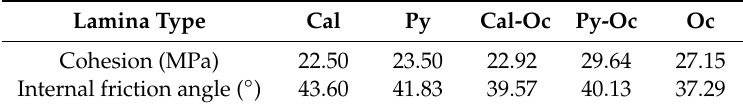
Figure 7. Shear strength parameters for different Longmaxi Shale laminae. Table 2. Shear strength parameters of the Longmaxi Shale laminae.